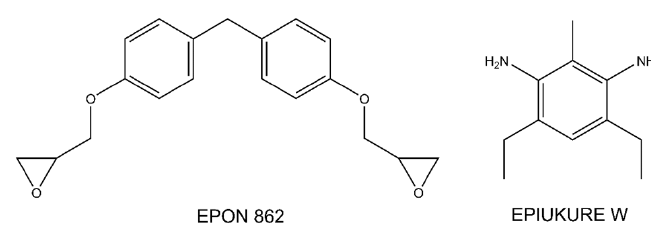
Figure 2. Molecular structure of benzoxazine. Figure 3. Molecular Structure of difunctional epoxy.